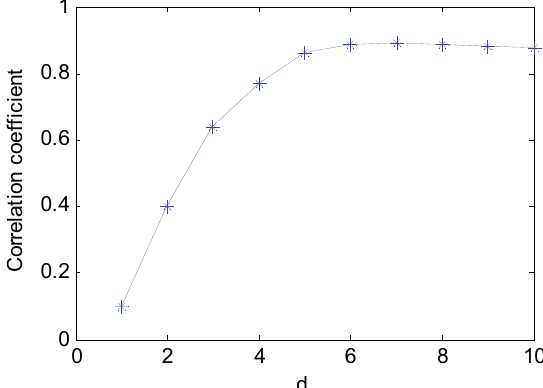
Fig.10. Correlation coefficient of oil production time series